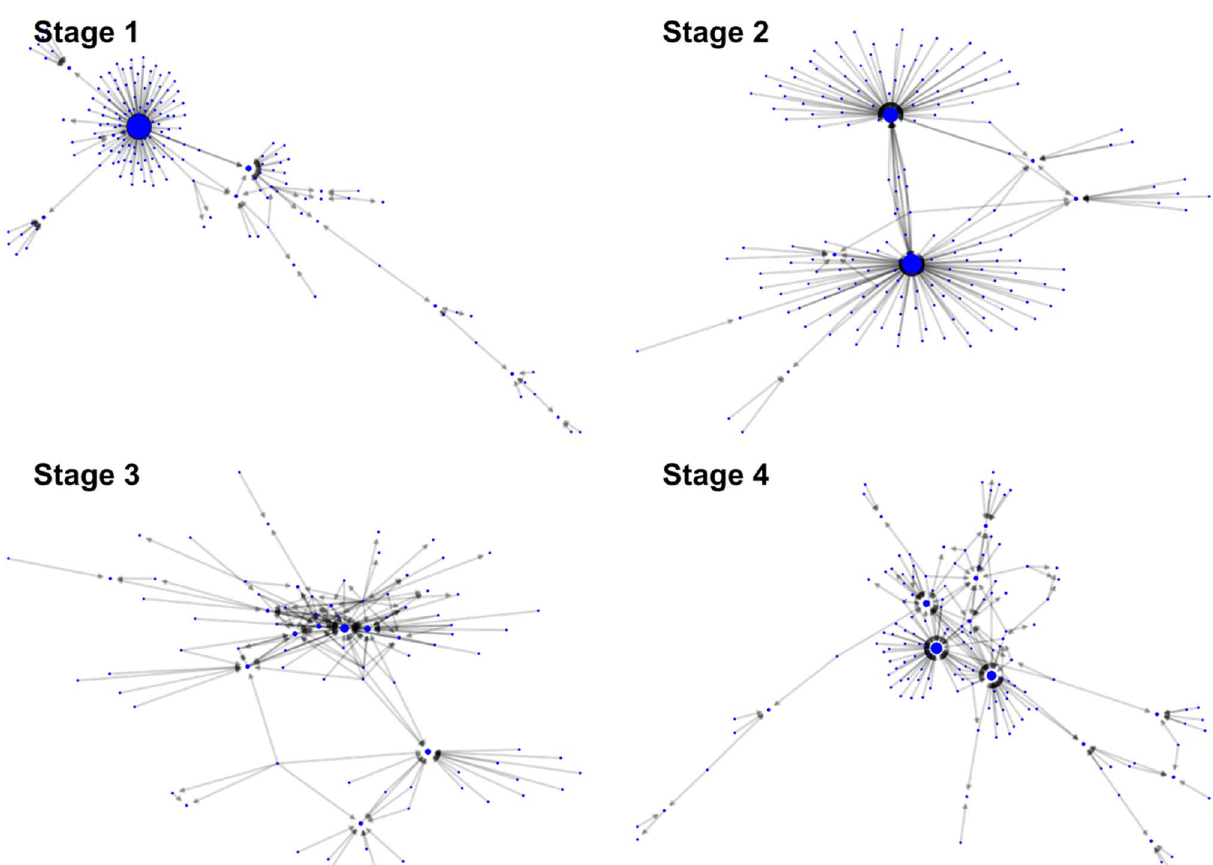
Figure 3. Communication networks by the stages of